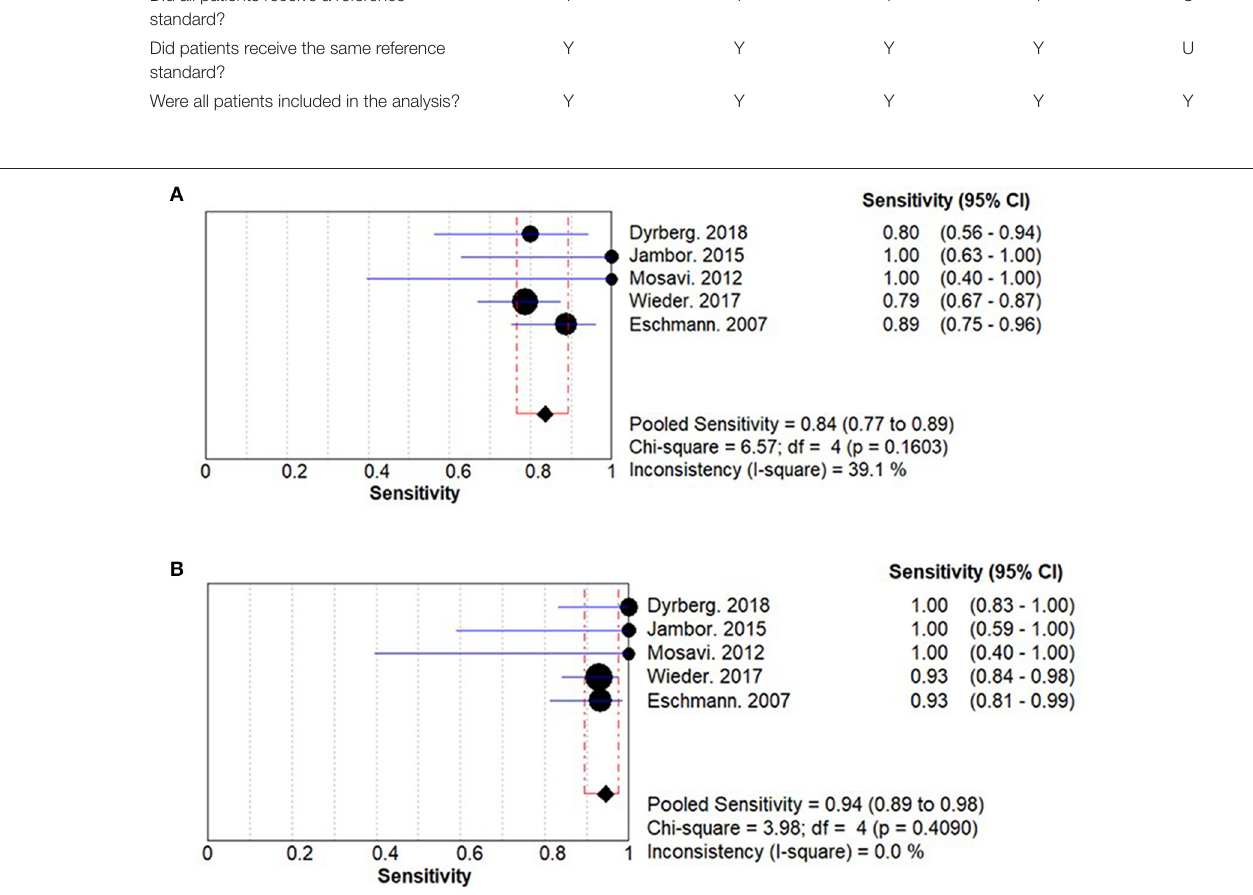
FIGURE 2 | Summary results for sensitivity for whole-body magnetic resonance imaging (WBMRI) (A) and positron emission tomography/computed tomography (PET/CT) (B) .